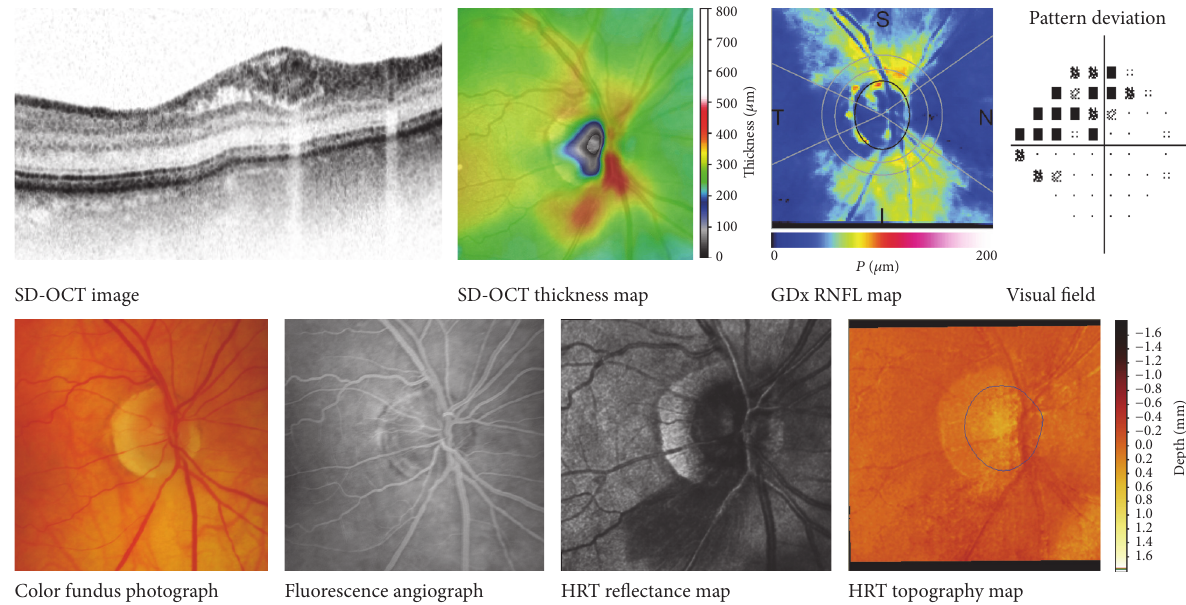
Figure 2: SD-OCT, scanning laser polarimetry (GDx), visual field, color fundus photograph, fluorescence angiograph, and scanning laser tomography (HRT) images during the presence of the focal retinoschisis in Case 6. The SD-OCT image shows the retinoschisis inferotemporally (see thickness map). The thickness map shows the total retinal thickness. The GDx shows no increased RNFL thickness. The color fundus photograph as well as the fluorescein angiography shows no clear signs of the retinoschisis, except for atherosclerotic arteries inferiorly to the ONH. The HRT shows a darker area at the thickened location in the reflectance map, as well as a slight increased height in the topography map. SD-OCT: spectral domain optical coherence tomography; RNFL: retinal nerve fiber